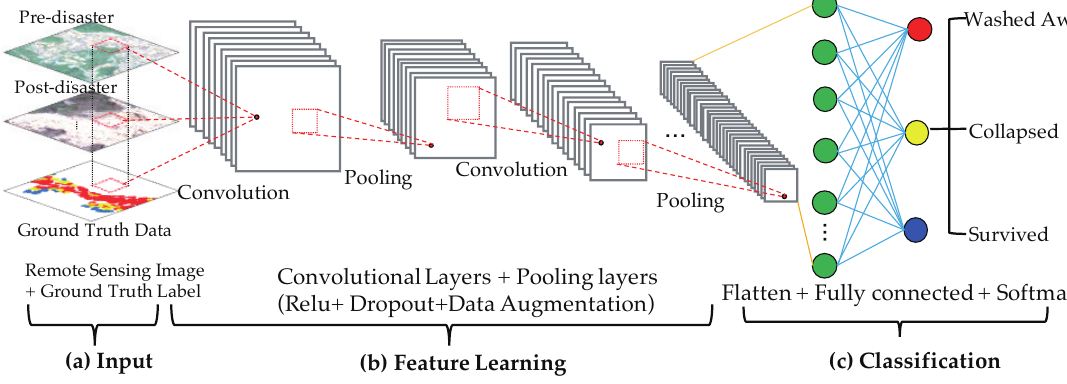
Figure 13. The convolutional neural network (CNN) architecture including the convolutional, pooling, and fully connected layers. ( a ) The input feature vector can be post-disaster and/or pre-disaster remote sensing image as well as the ground truth label. ( b ) Convolution and pooling operations alternate during feature learning, Rectified Linear Unit, dropout, and data augmentation operation are also employed to improve the efficiency of model training. ( c ) During the classification stage, a flatten operation, fully connected layer, and loss function such as softmax function is adopted to convert the pooled feature map into a 1D feature vector for tsunami damage